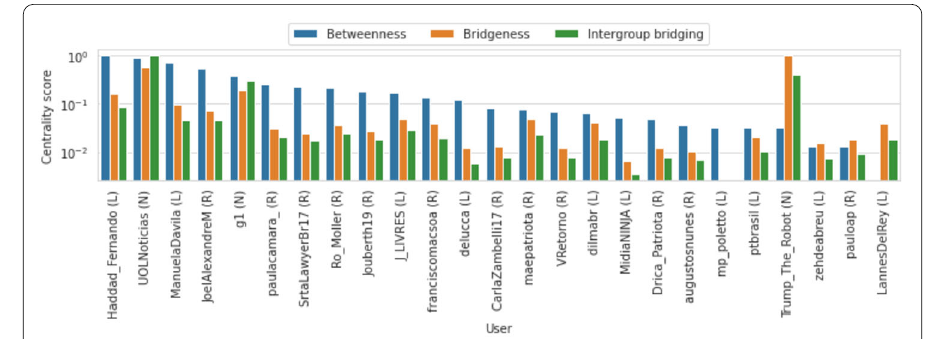
account banned from Twitter after data collection, was ranked higher than @UOLNoti- cias and @G1. And finally, on the third representation for intergroup bridging centrality, nodes from polarized groups also were not highlighted. However, in contrast to bridgeness centrality, @UOLNoticias ranked higher than @Trump_The_Robot and @G1. This same pattern prevailed in other weeks. For Canada (not shown due to lack of space), the inter- group bridging also helps to highlight important nodes that receive the attention of users from different sides of the political spectrum. These findings regarding the effectiveness of the intergroup bridging centrality algorithm speak to our first research